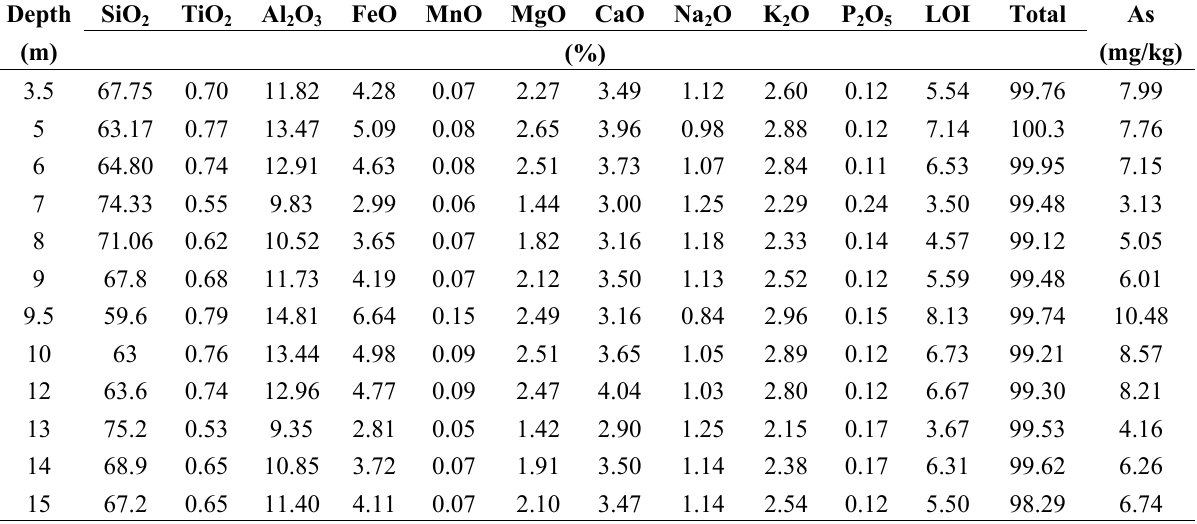
Table A2. Concentrations of arsenic (mg/kg) and major elements (%w/w) in core samples of